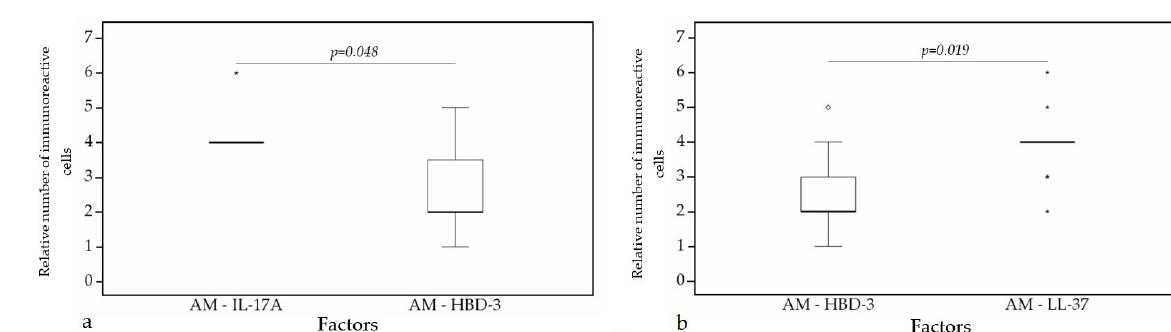
Figure 14. Wilcoxon test revealing statistically significant difference between the relative numbers of different factors in alveolar macrophages. ( a ) A statistically significant difference between IL-17A and HBD-3 in alveolar macrophages. ( b ) A statistically significant difference between HBD-3 and LL-37 in alveolar macrophages. AM, alveolar macrophages; HBD-3, human β defensin 3; LL-37, cathelicidine; IL-17A, interleukin 17A; o—outlier data—indicates a higher or lower number of relative positive cells which lie more than 1.5 but less than 3.0 times the interquartile range below the first quartile or above the third quartile; *—extreme outlier data—indicates a higher or lower number of relative positive cells which lie more than 3.0 times the interquartile range below the first quartile or above the third quartile. Table 4. Spearman’s rank correlation coefficient revealed correlations between the relative numbers of different factors in healthy lung tissue.